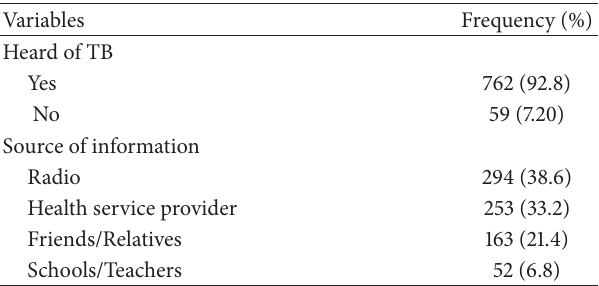
Table 1: Sociodemographic characteristics of the study population ( 𝑛 = 821 ).